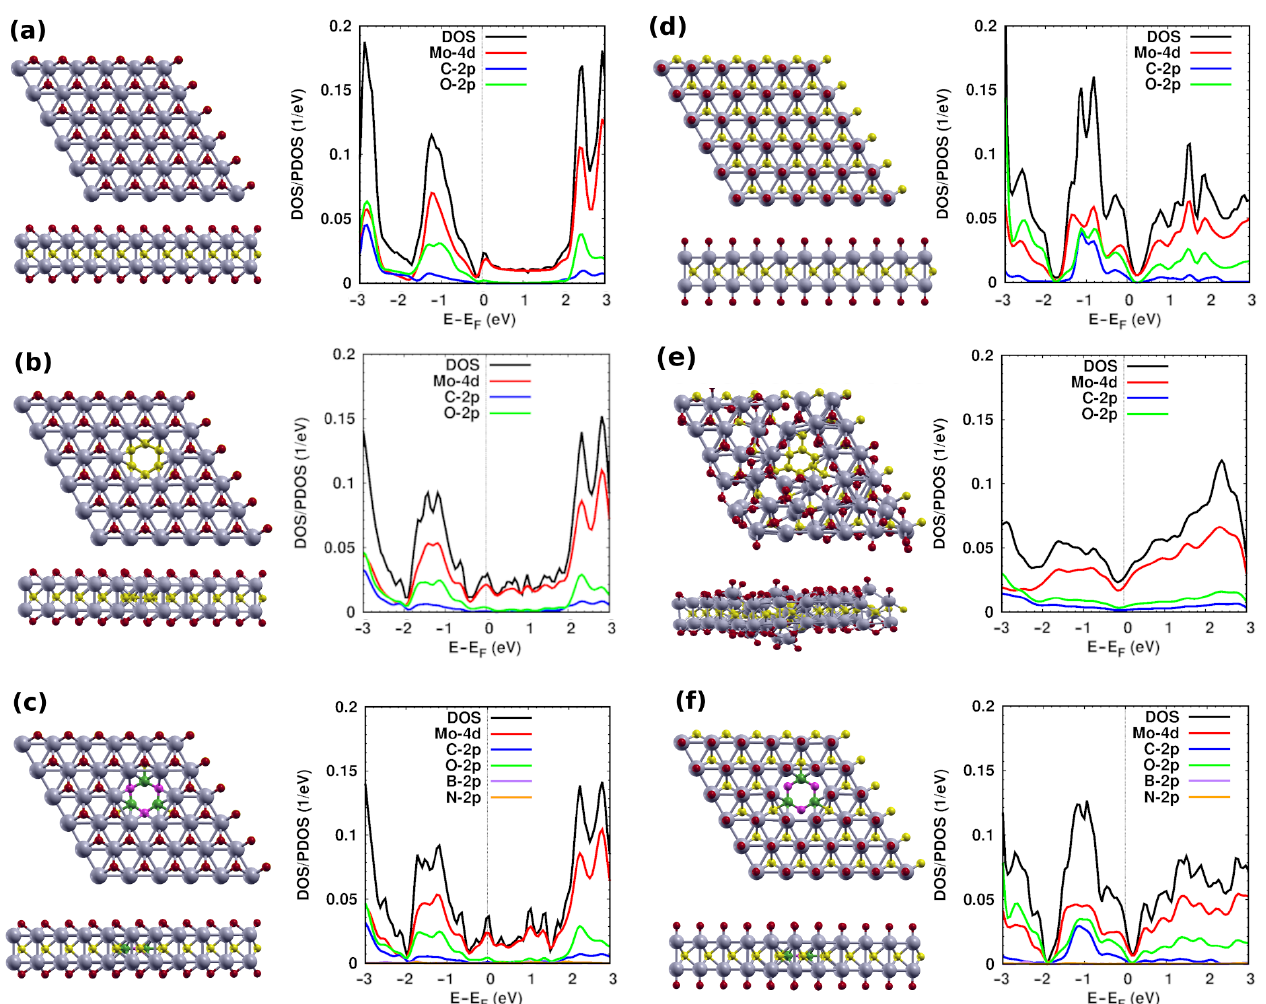
Figure 2. The optimized structures with O termination, top and side views, and DOS/PDOS of atoms are shown in gray, yellow, red, green, and pink,